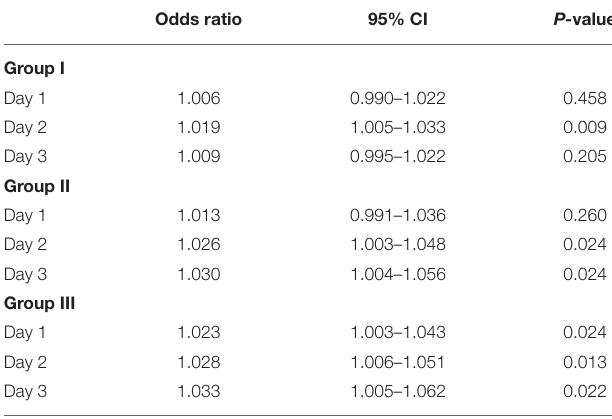
TABLE 1 | Comparison of serum sCD40L among patients with normal appendices, simple appendicitis, gangrenous appendicitis, and ruptured appendicitis on the first 3 days after onset of symptoms.